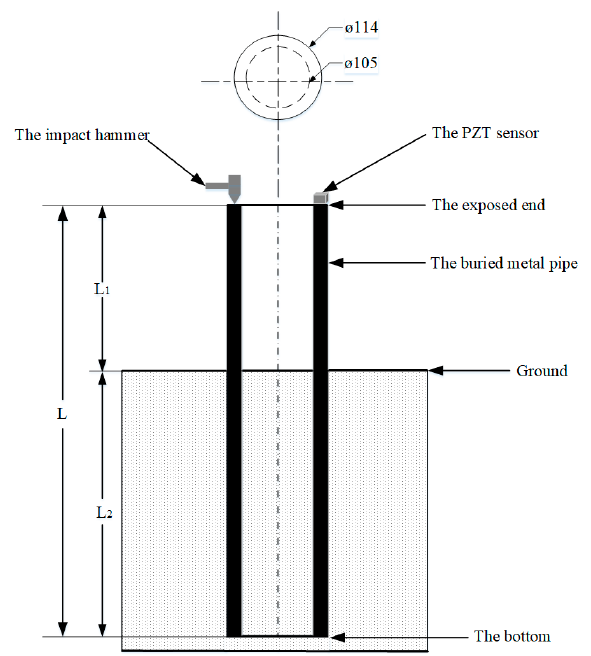
Figure 2. Schematic diagram of measuring the length of the buried column by the stress wave method.